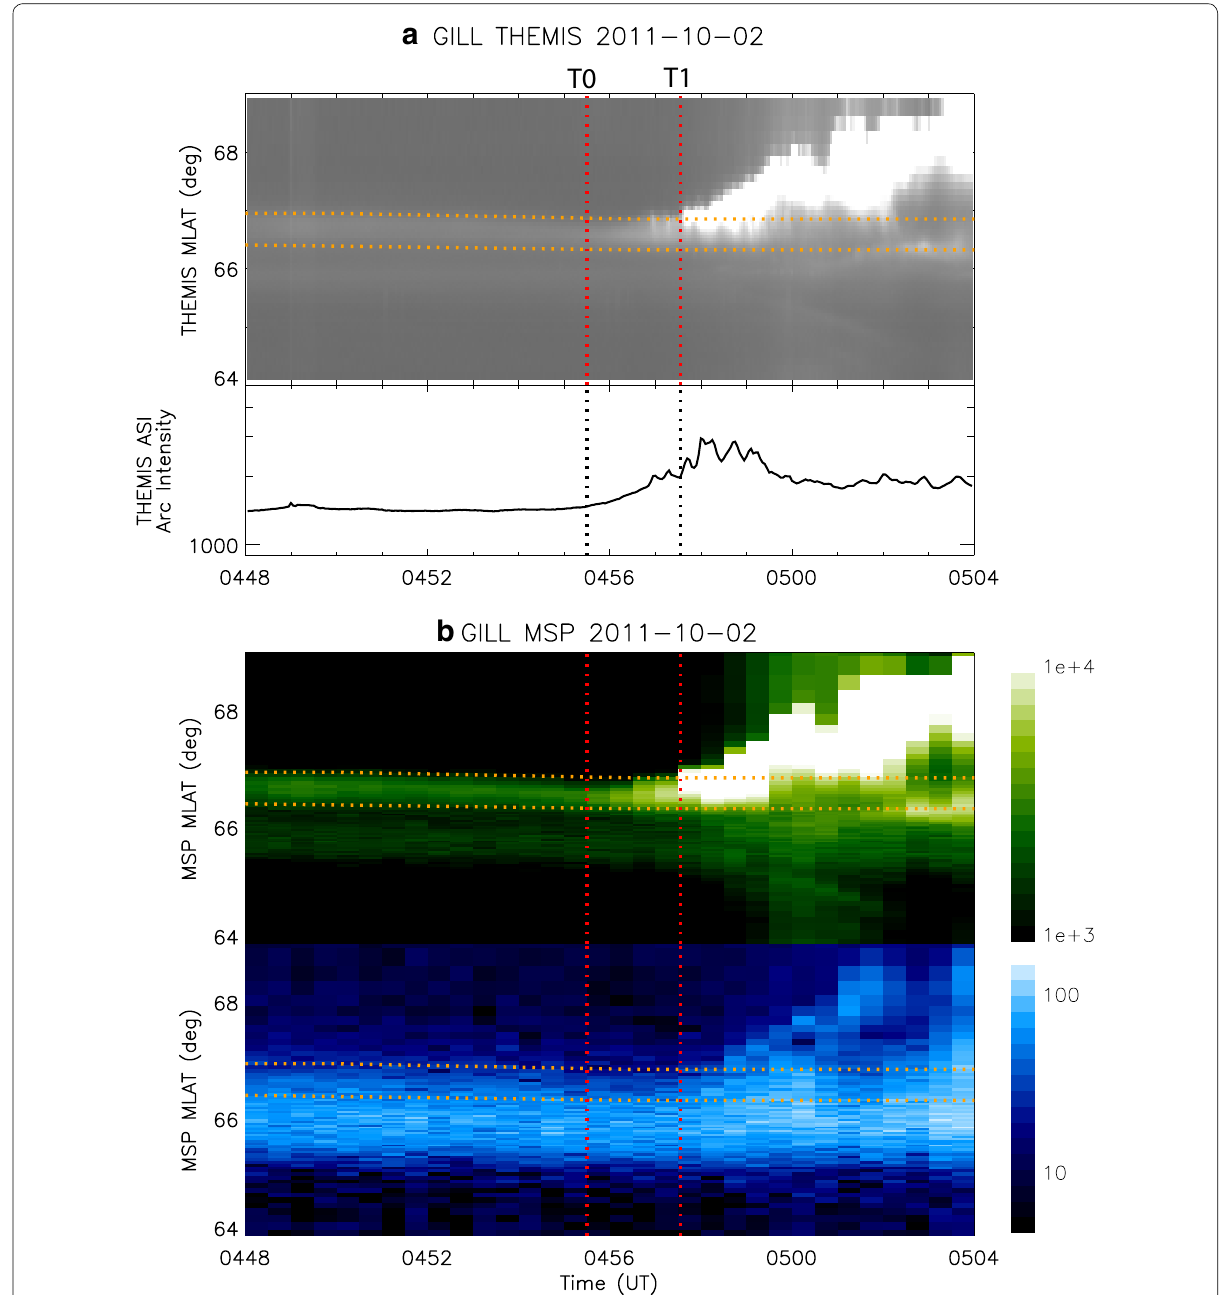
Fig. 2 THEMIS ASI keogram and MSP observations. Top panel of a shows the THEMIS ASI keogram constructed along the MSP scan line. The arc band is shown in orange dotted lines. The lower panel of a shows the ASI counts sampled and averaged over the arc band along the MSP scan line. In b , the upper and lower panels show the 557.7 green-line intensities and 486.1 nm proton auroral intensities, versus time and latitude. The arc band is also labeled. Two vertical dotted line throughout the plot denote T 0 and T 1, the TSSO